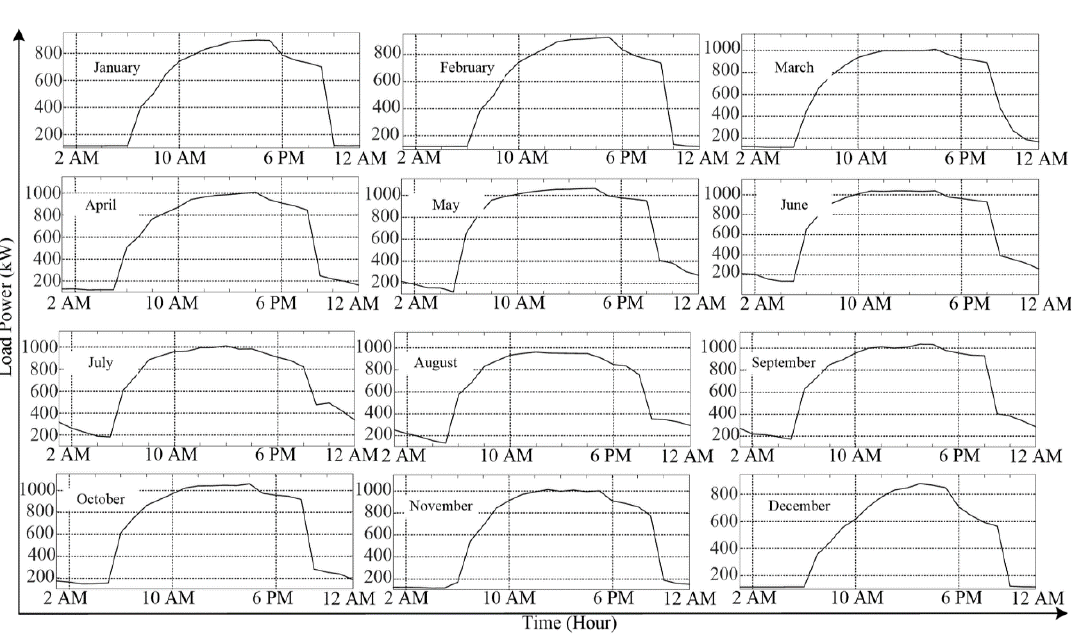
Figure 3. Monthly average load